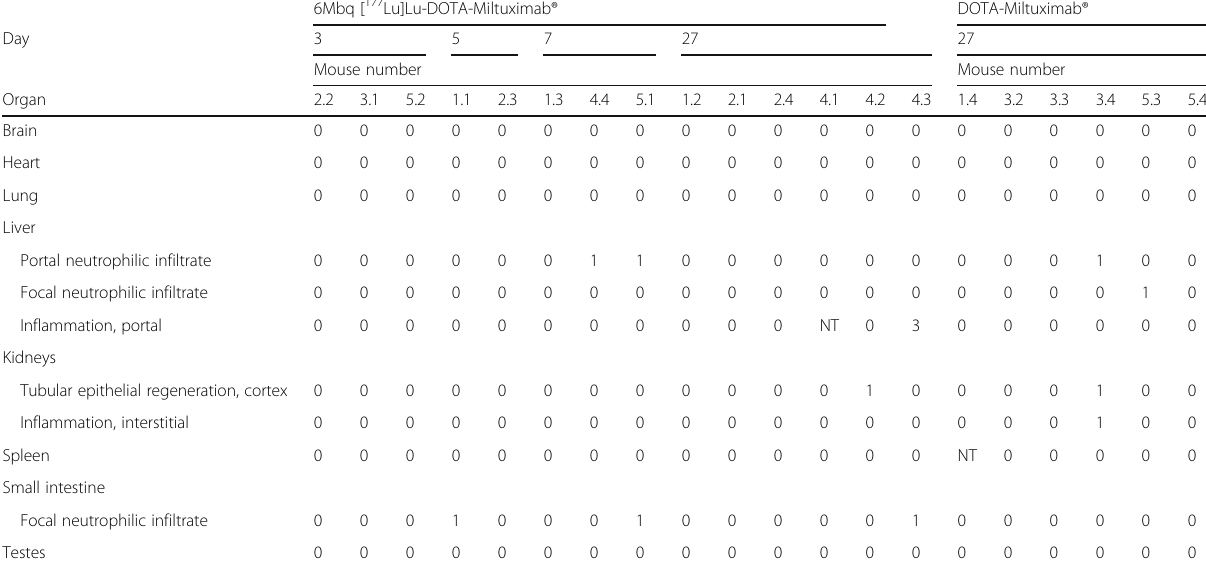
Table 1 Histopathological assessment of mice treated with DOTA-Miltuximab® or 6Mbq [177Lu]Lu-DOTA-Miltuximab® on days 3, 5, 7 and 27 Day Organ Brain Heart Lung Liver Portal neutrophilic infiltrate 0 Focal neutrophilic infiltrate Inflammation, portal Kidneys Tubular epithelial regeneration, cortex Inflammation, interstitial